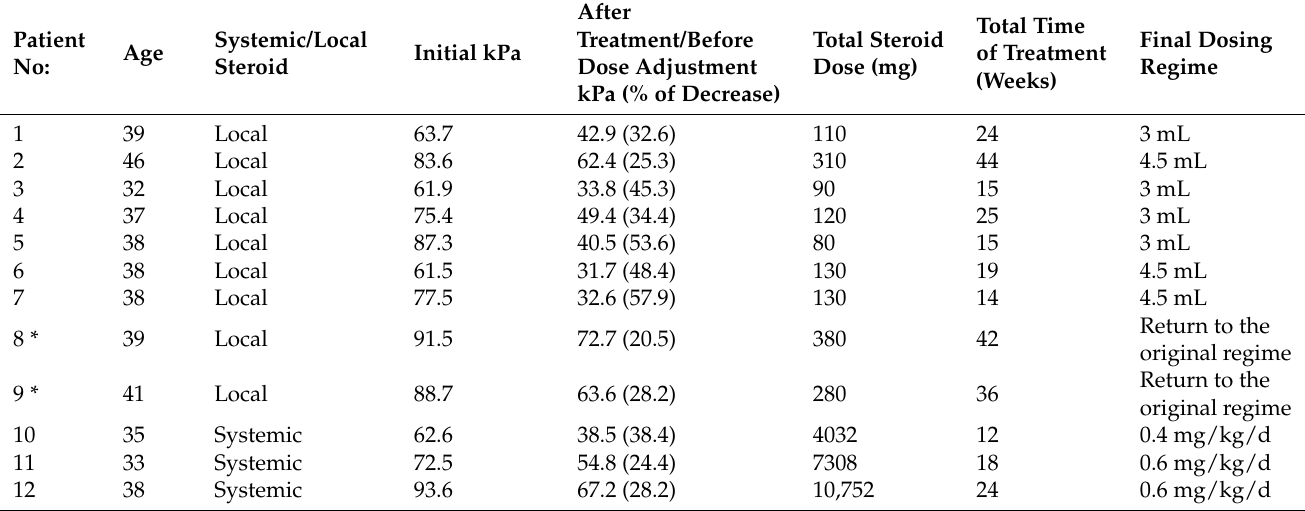
Table 1. Detailed information about study